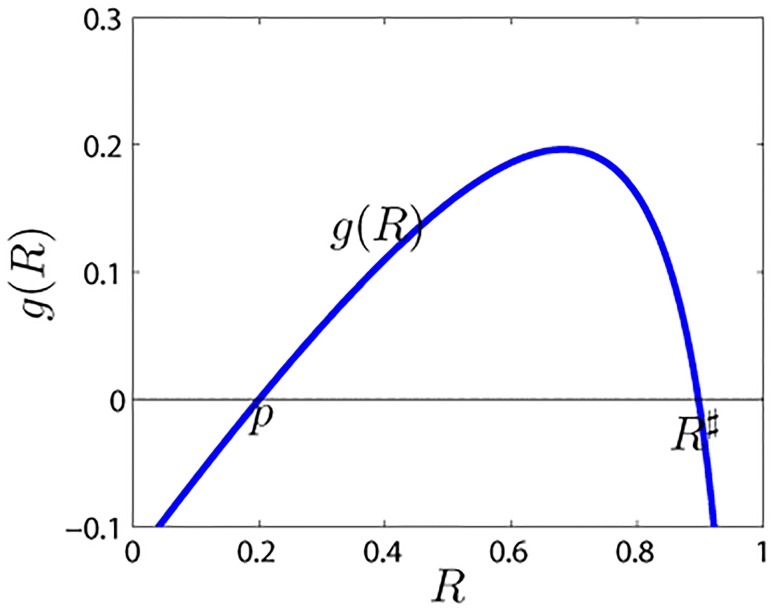
Shape of the function g(R).The parameters are β=0.03,γ=0.15,θ=0.45,α=0.25,δ=0.35,k¯=10, and p = 0.2.